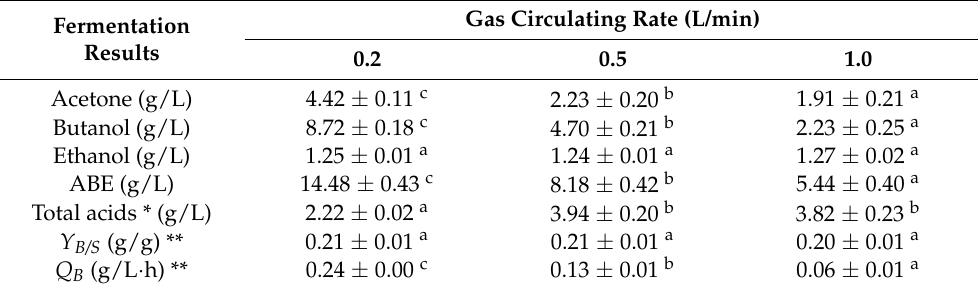
Table 2. Butanol production in a bubble column bioreactor under various gas circulation rates after 36 h of